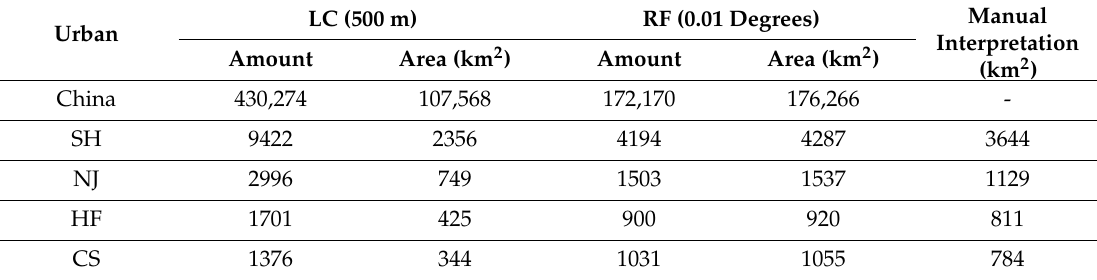
Table 5. The number of urban pixels and area from MODIS land cover (LC), the RF classifier, and the manual interpretation results for China and the four cities (Shanghai (SH), Nanjing (NJ), Hefei (HF), and Changsha (CS)). The rectangular region in Figure 8 is the city region and not the administrative